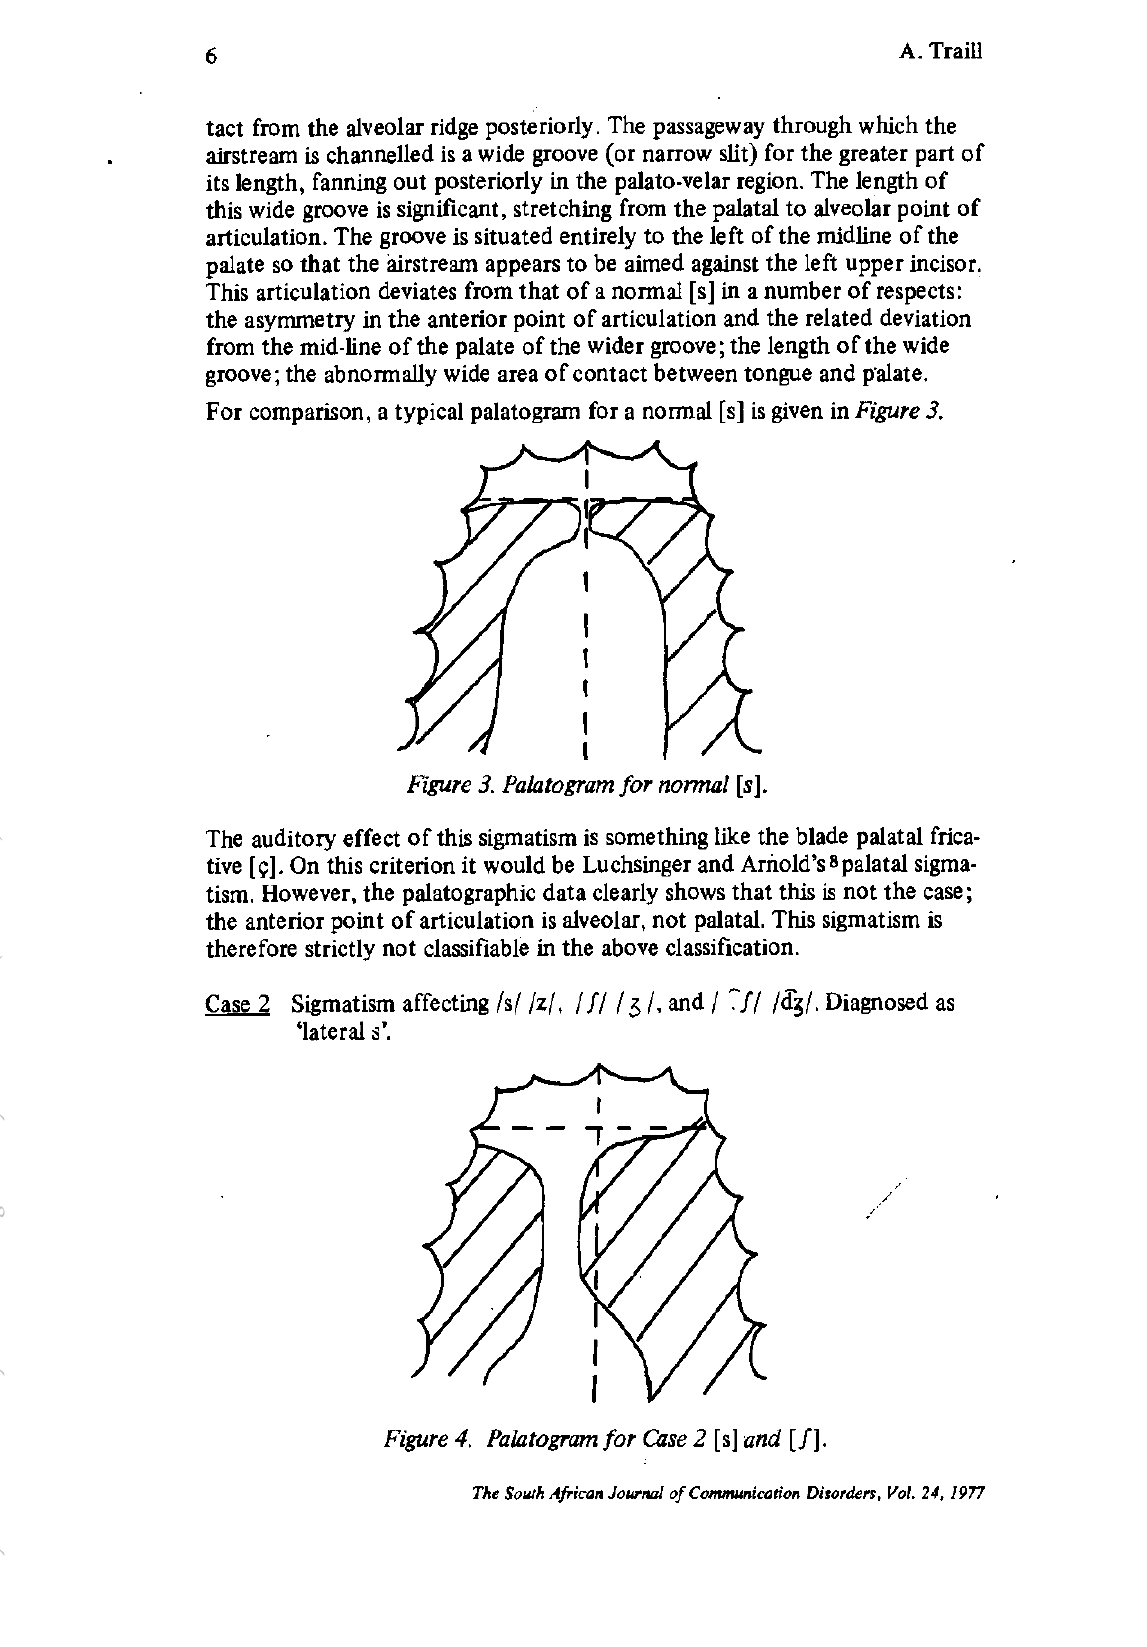
Figure 4. Palatogram for Case 2 [s] and